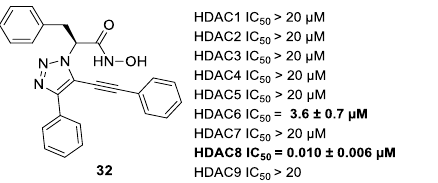
Table 5. General structure and IC 50 values of 27 , 28 , 29 , 30 and 31 [24].